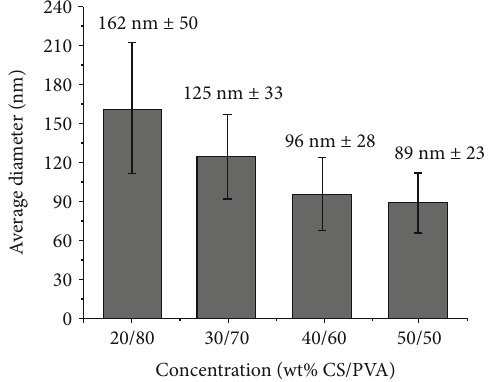
Figure 5: Average diameter of the electrospun CS/PVA nano fi bers at di ff erent weight ratios (voltage 15kV, distance 15